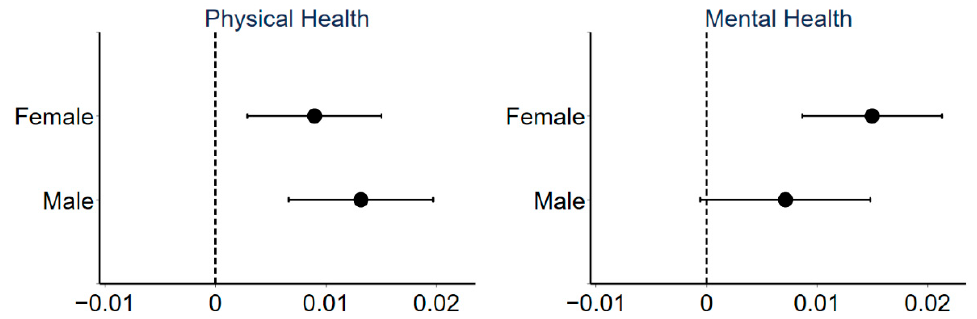
Figure 3. Coefficients and 90% confidence intervals of regressions for different gender group.